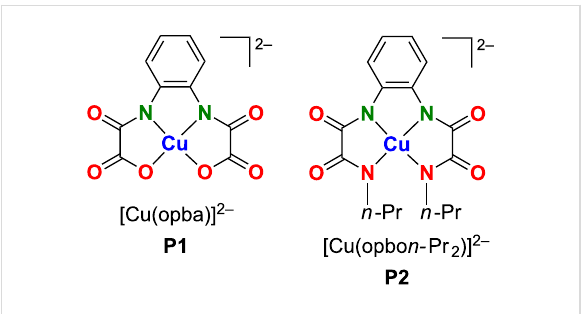
Figure 1: Chemical structures of the anionic complex fragments [Cu(opba)] 2 − ( P1 , left) and [Cu(opbo n -Pr 2 )] 2 − ( P2 ,